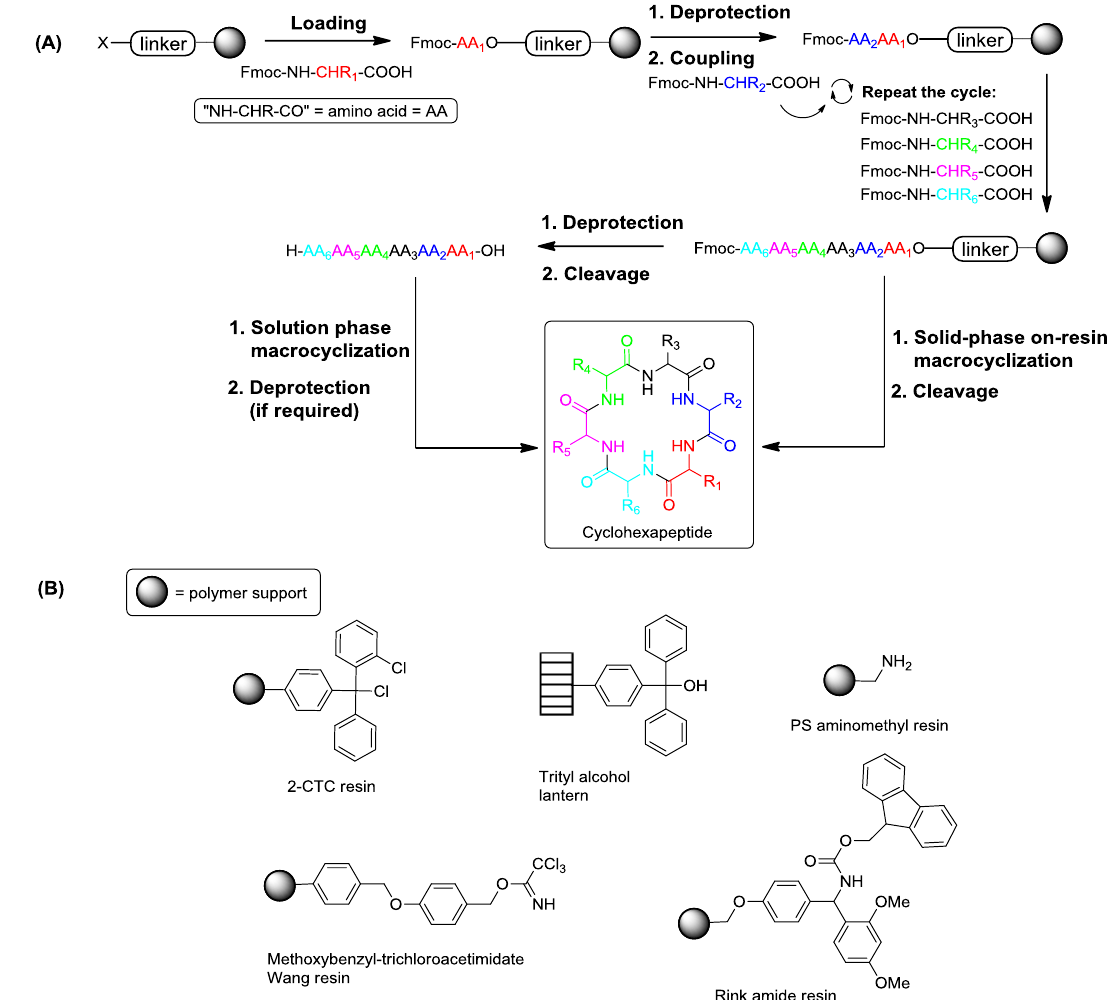
Figure 1. ( A ). Illustration of solid-phase cyclohexapeptide synthesis. ( B ). Resins highlighted in this review.